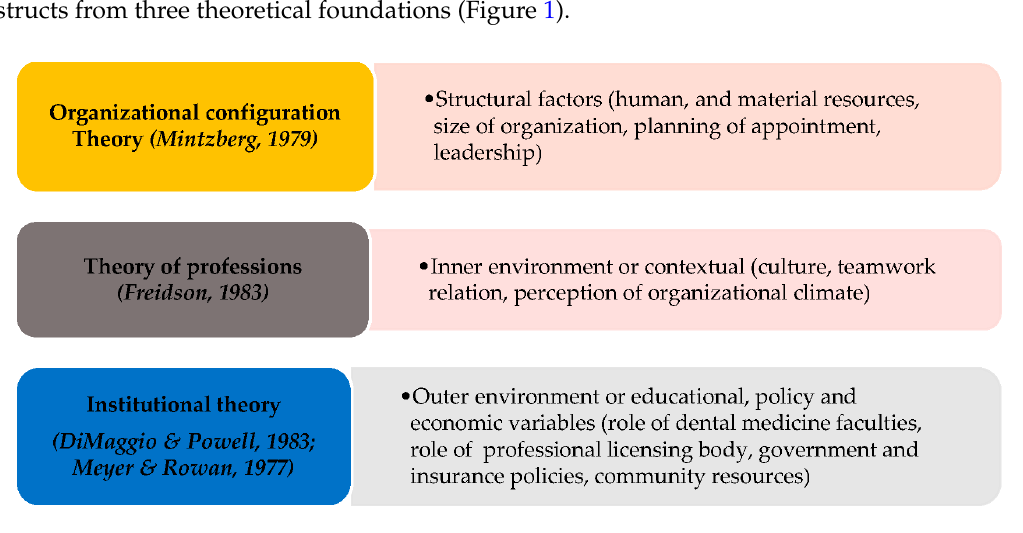
Figure 1. Integrative theoretical model for the study on environmental factors in dental practice settings.